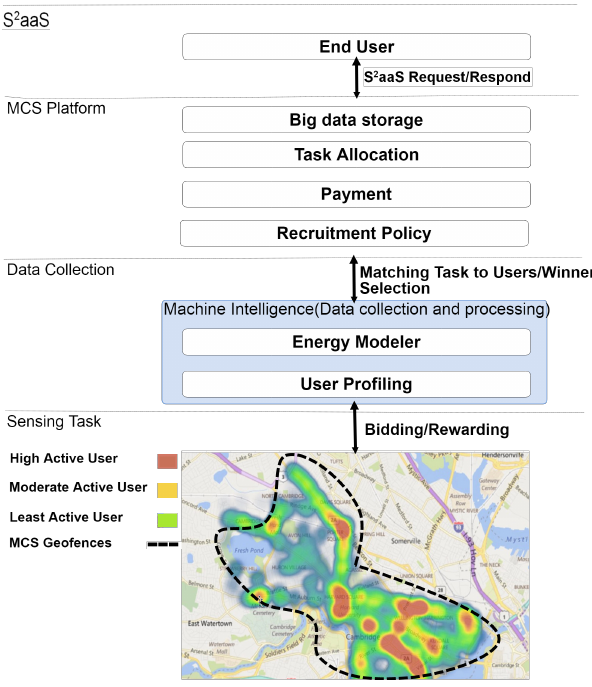
Figure 2. System